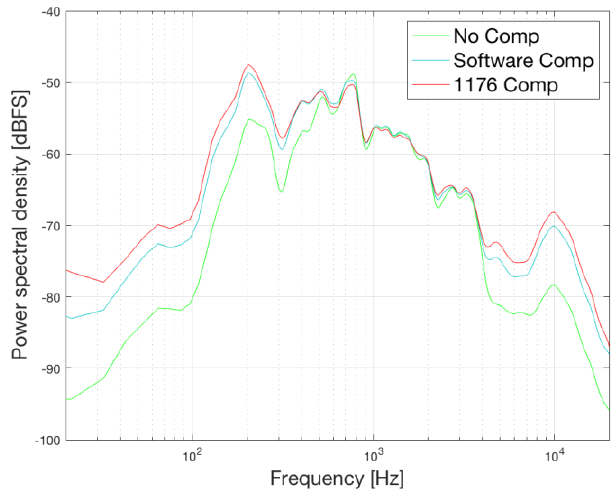
Figure 8. Long-term average spectrum (LTAS) measurement from the uncompressed audio (green), the clean software compressor (blue) and the 1176 compressor in all-buttons mode (red).